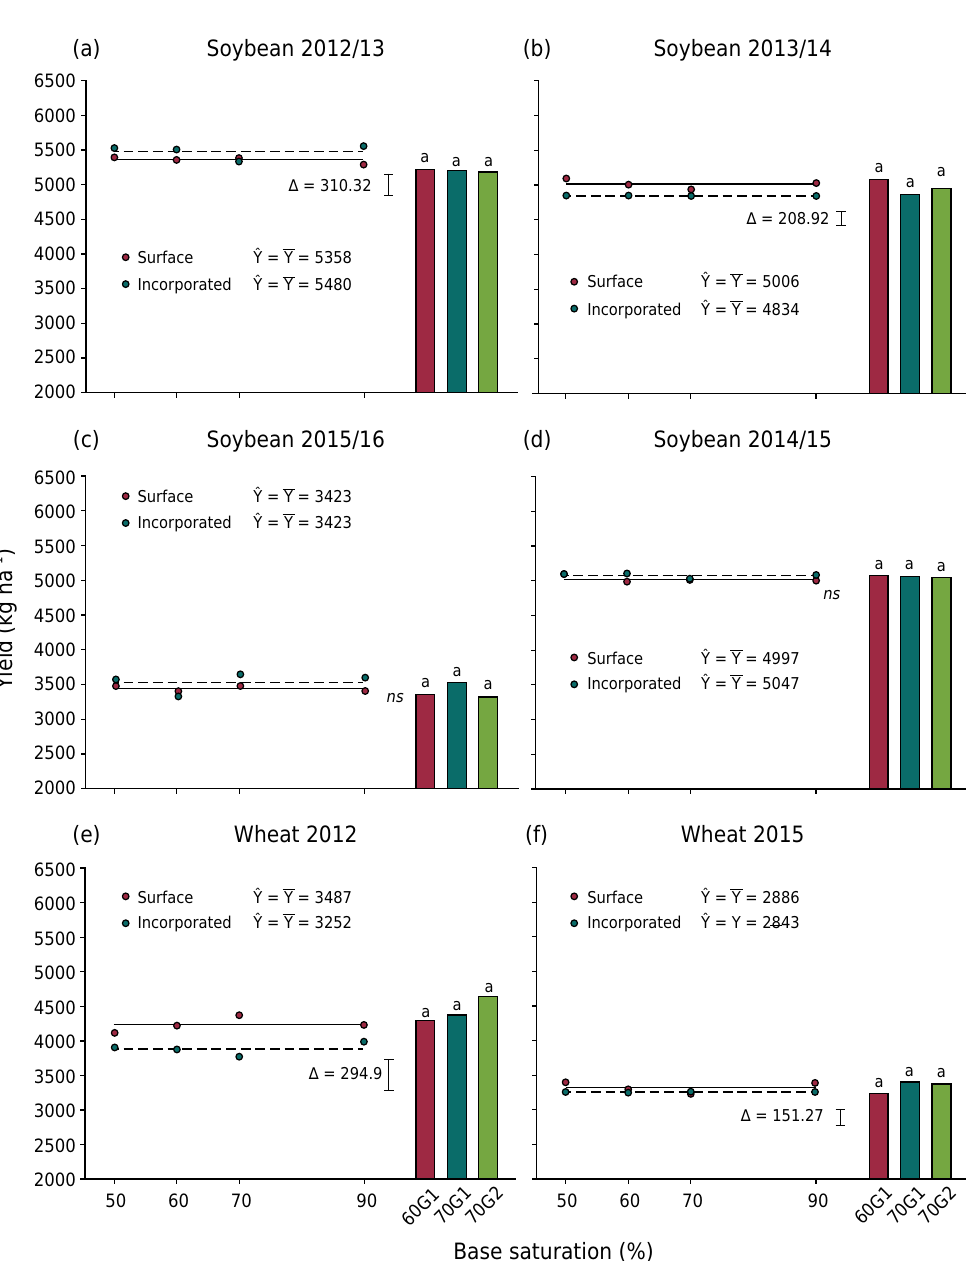
Using phosphogypsum together with lime did not bring extra benefits to the decrease in soil acidity at 48 months post-application, as also observed by Costa and Crusciol (2016). In our study, phosphogypsum did not alter Al 3+ levels, in agreement with Zambrosi et al. (2007), who found no effects at 55 months after applying up to 9 Mg ha -1 phosphogypsum. Such a result may be attributed to the low soil Al 3+ content (Fontoura et al., 2019). However, Caires et al. (1999) observed a reduction in soil Al 3+ in the 0.05-0.10, 0.20-0.40, 0.40-0.60, and 0.60-0.80 m layers at 14 months after phosphogypsum application to a Latossolo (pH 4.5 and 0.6 cmol dm -3 Al 3+ in the 0.00-0.20 m layer). The basic dissociation c rate of phosphogypsum is 8.3 × 10 -13 , which is considered to be very low. Under soil